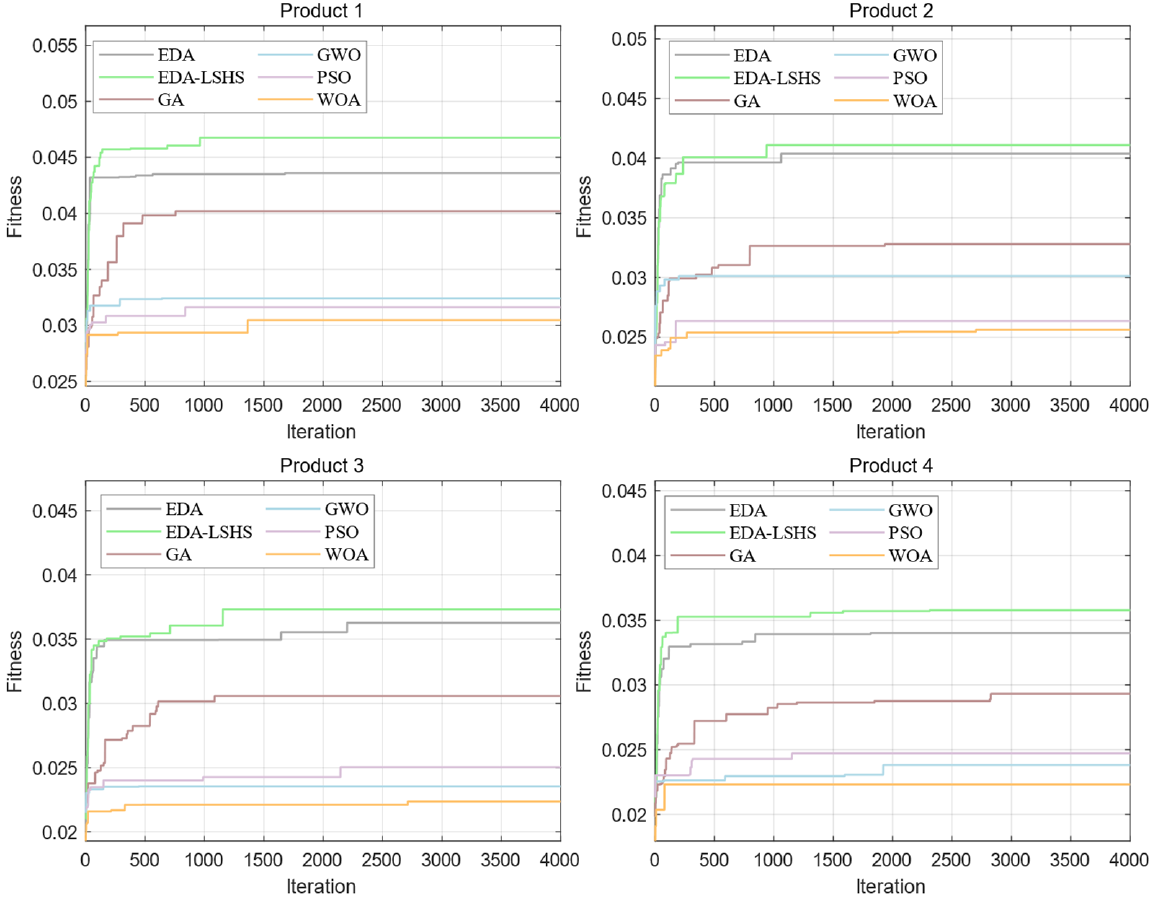
Figure 7. The convergence curves of different algorithms in four product instances.